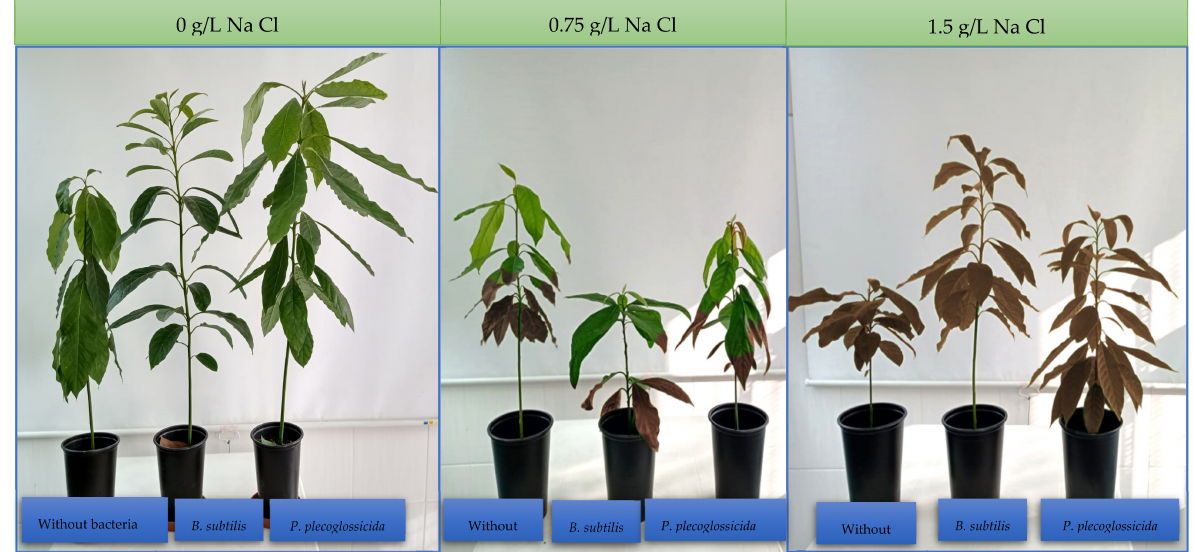
Figure 4. Effect of the inoculation of PGPR on the growth of Persea americana var. Zutano under salinity stress